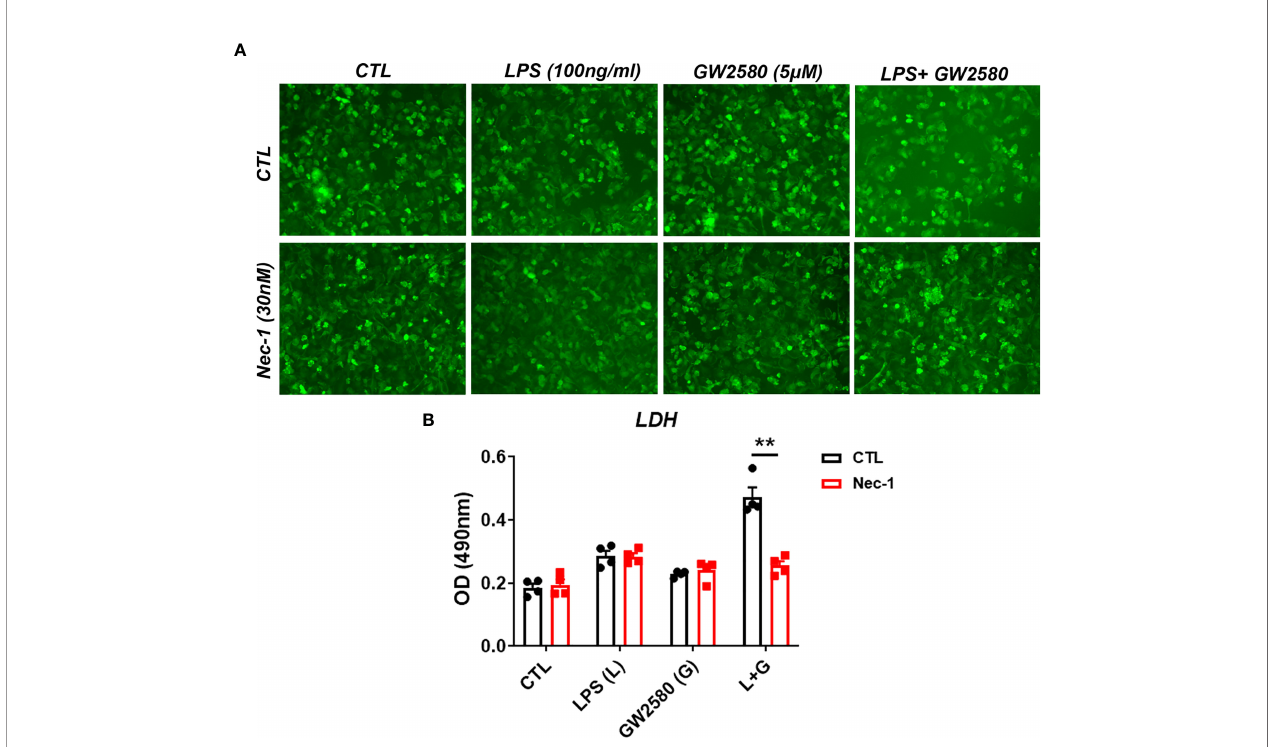
FIGURE 8 | Treatment with the RIP1 inhibitor Nec-1 inhibits cell death in GW2580 and LPS treated cultures. (A, B) Primary microglia were treated with either media, LPS (100ng/ml), GW2580 (5µM), or LPS and GW2580 with and without Nec-1 (30nM) for 48h. (A) Microglia treatment with Nec-1, inhibitor of necroptosis, was used to inhibit cell death. (B) Cell death was addressed by LDH measurement. Data shown is expressed as means ± standard error (SE). Statistical signi fi cance is represented by p-value < 0.01